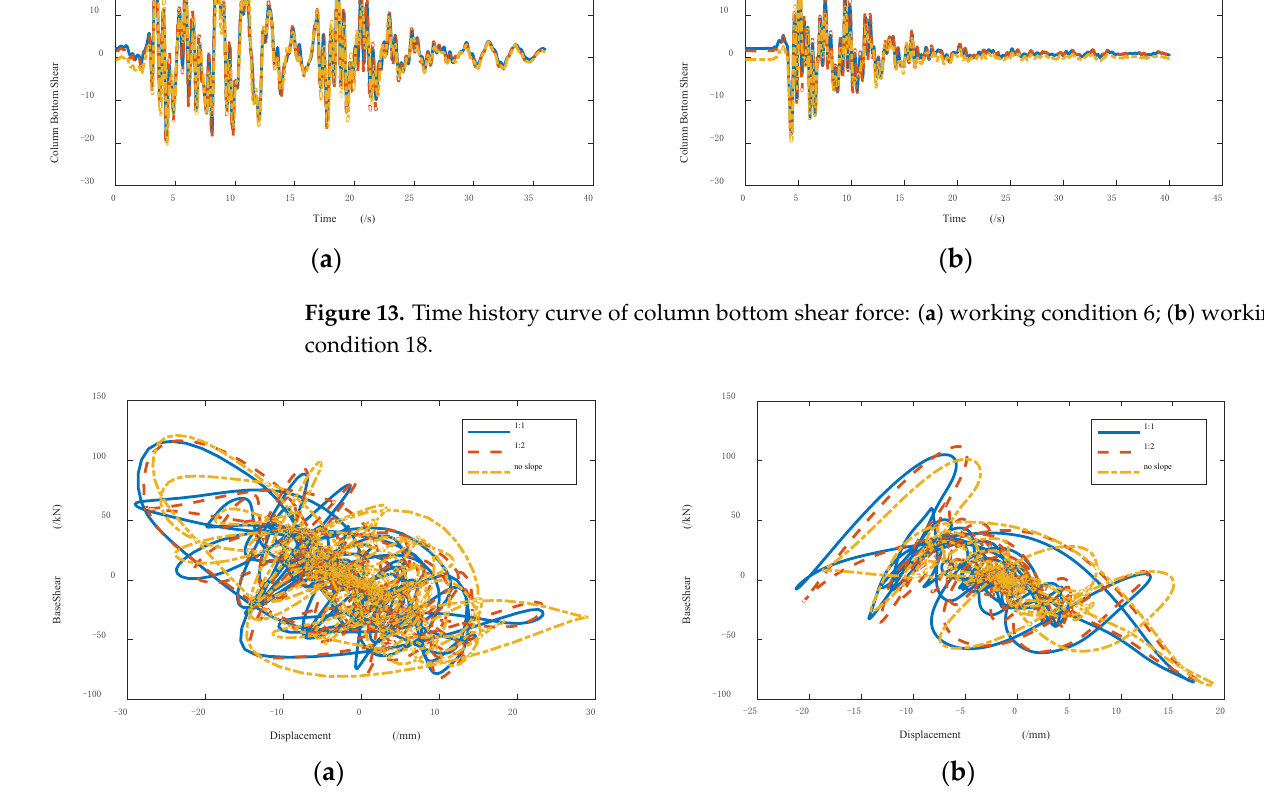
Figure 14. Base shear- top displacement hysteretic curve: ( a ) working condition 6; ( b ) working condition 18.